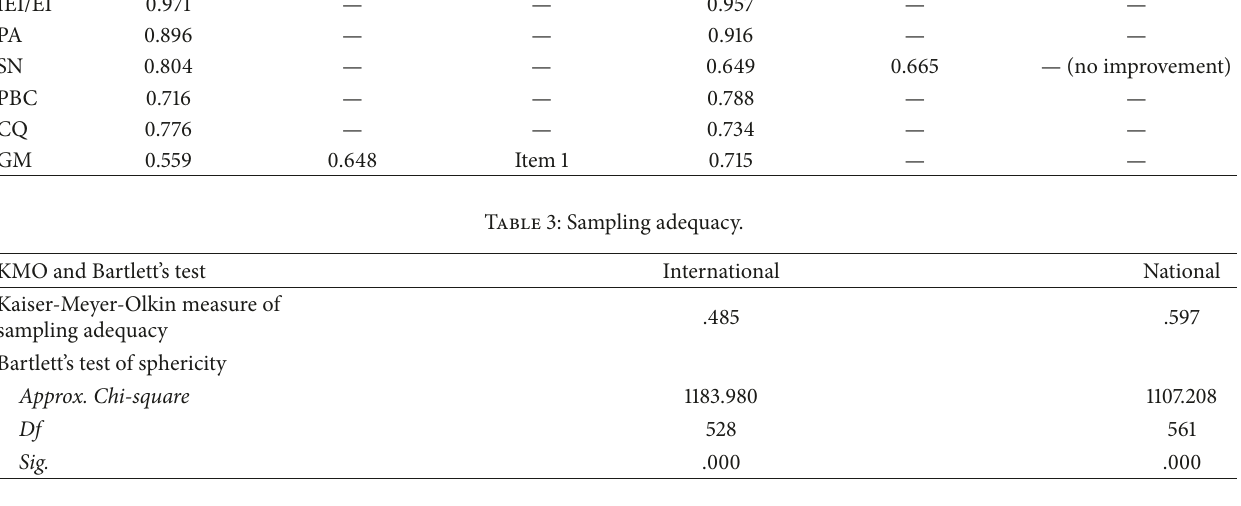
Table 2: Reliability statistics of the scales.